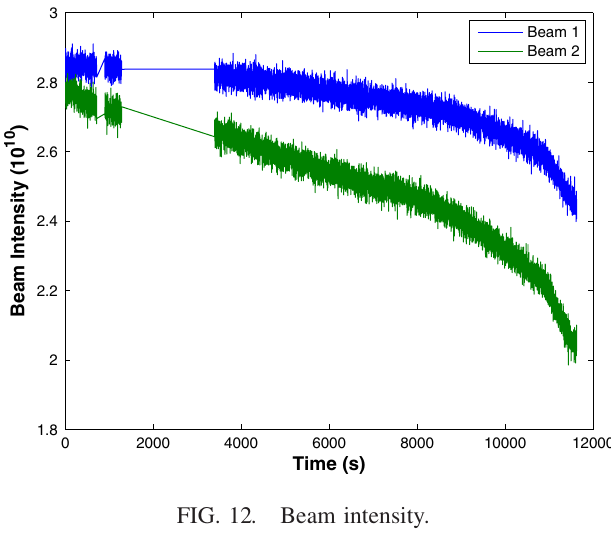
FIG. 12. Beam intensity.